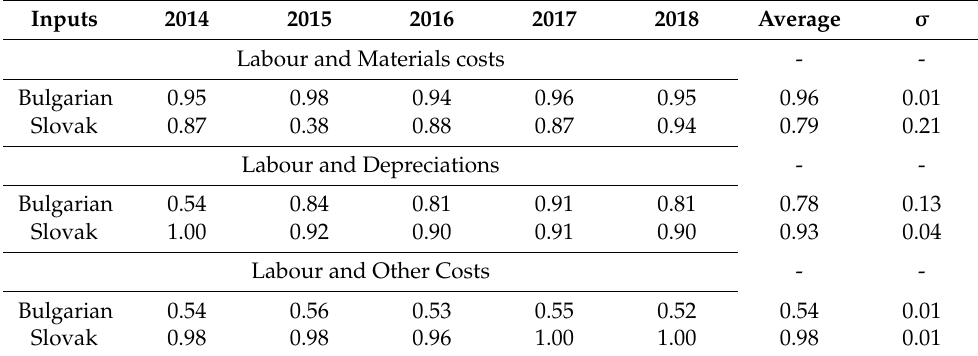
Table 1. Combined efficiencies of each country for the period of research. Inputs